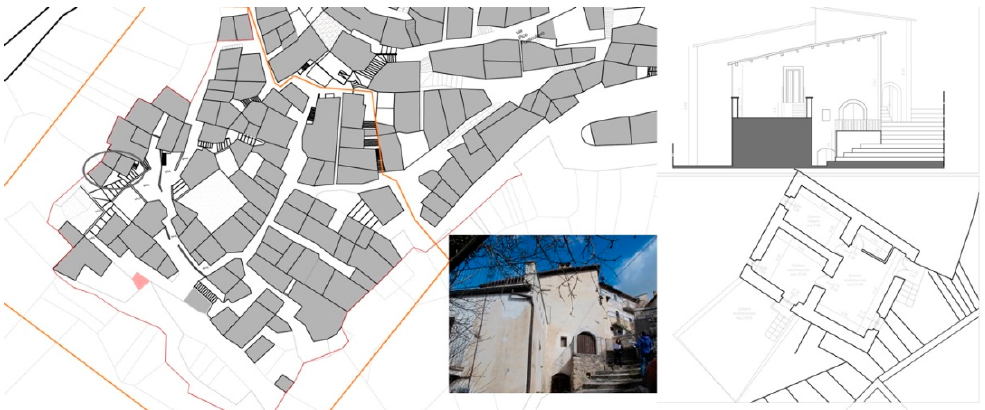
Figure 6. Point where the measurement was performed.